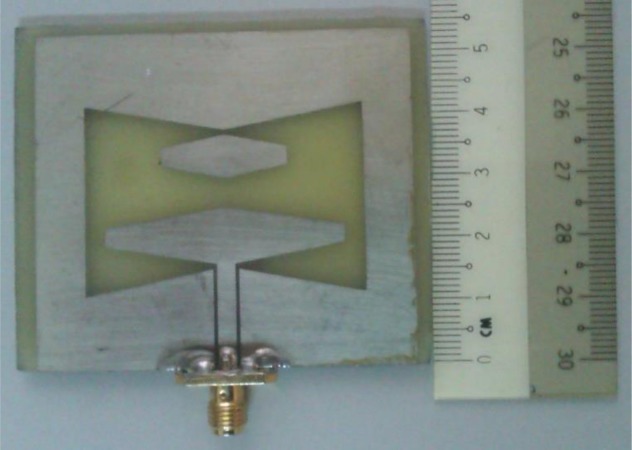
Fabricated Antenna.